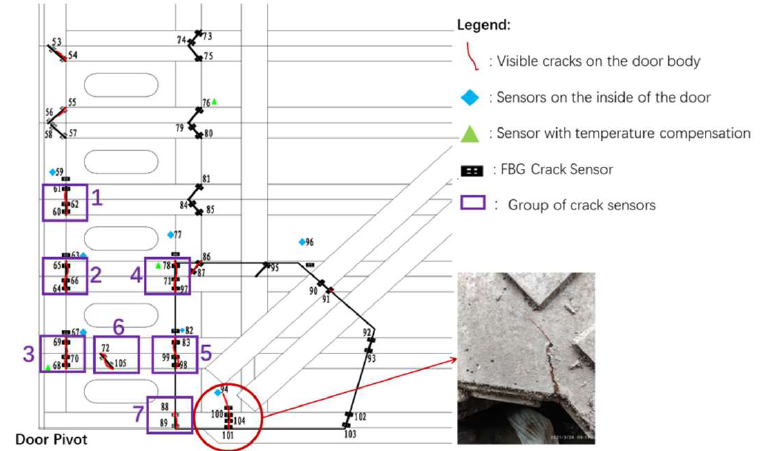
Figure 10. Schematic diagram of crack sensors layout near the door shaft area.